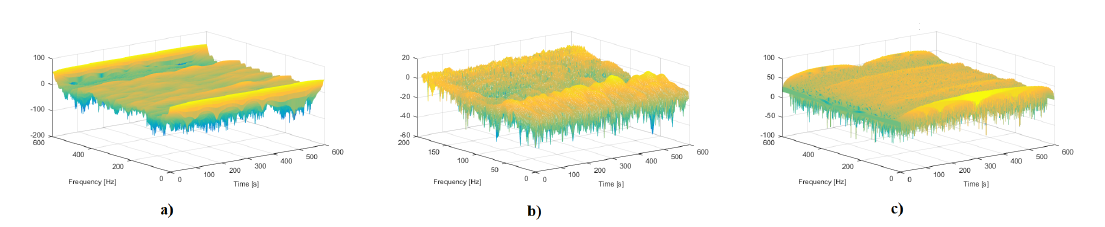
Figure 11. TF representations of measured roll responses: ( a ) STFT, ( b ) CWT and ( c )